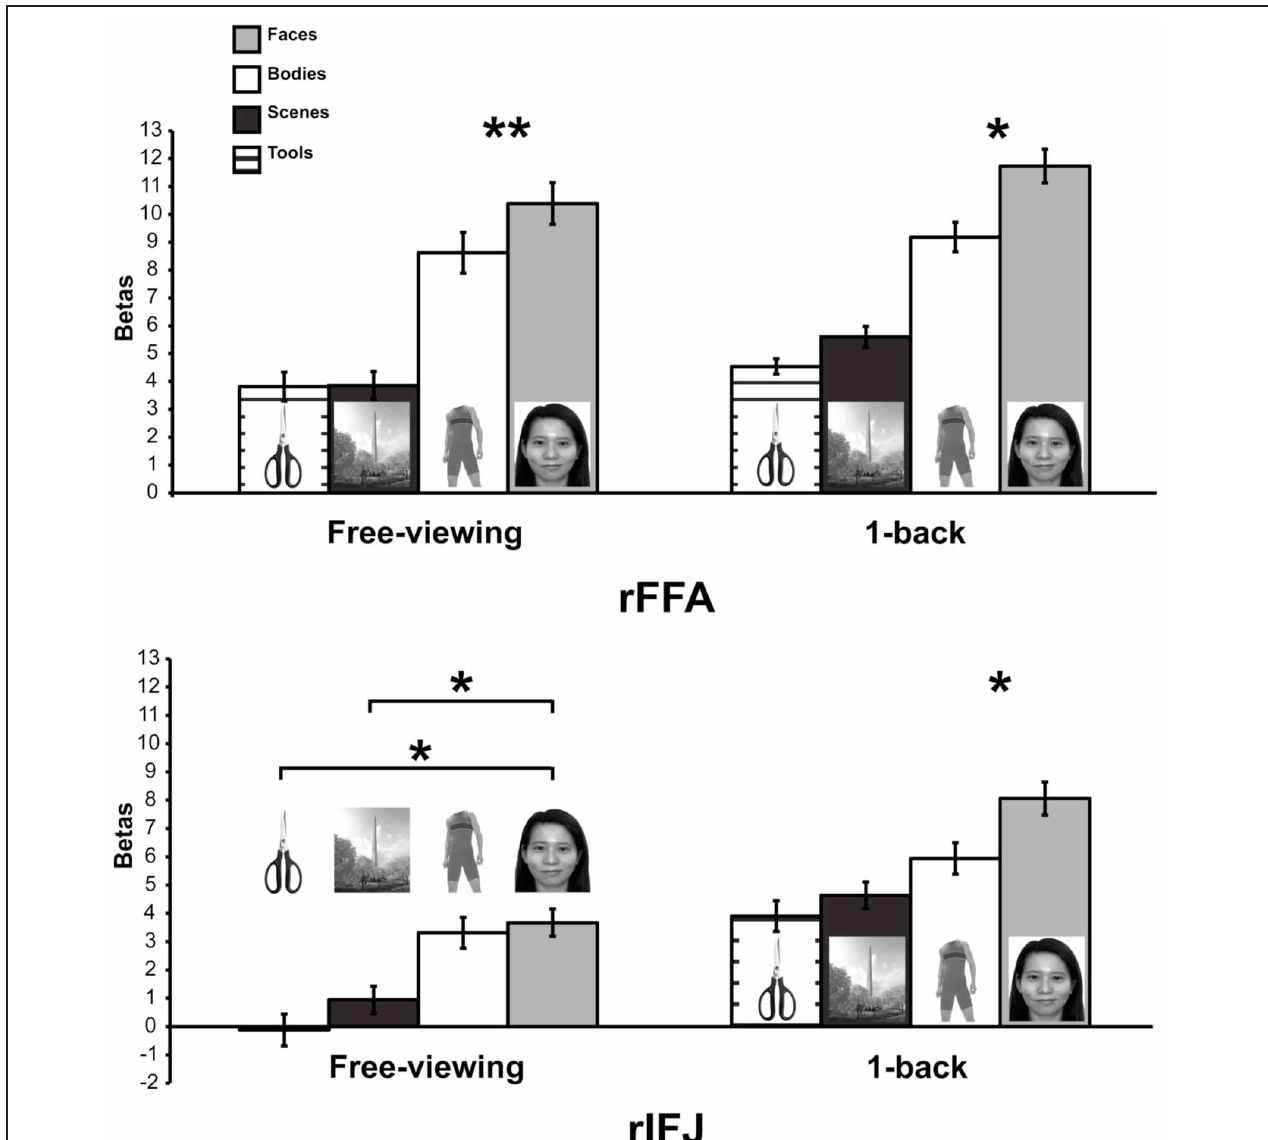
FIGURE 3 | Responses of rFFA and rIFJ, based on independent functional localizers, to faces, headless bodies, tools, and outdoor scenes, in both free-viewing and 1-back tasks. Response magnitudes indicate beta weights